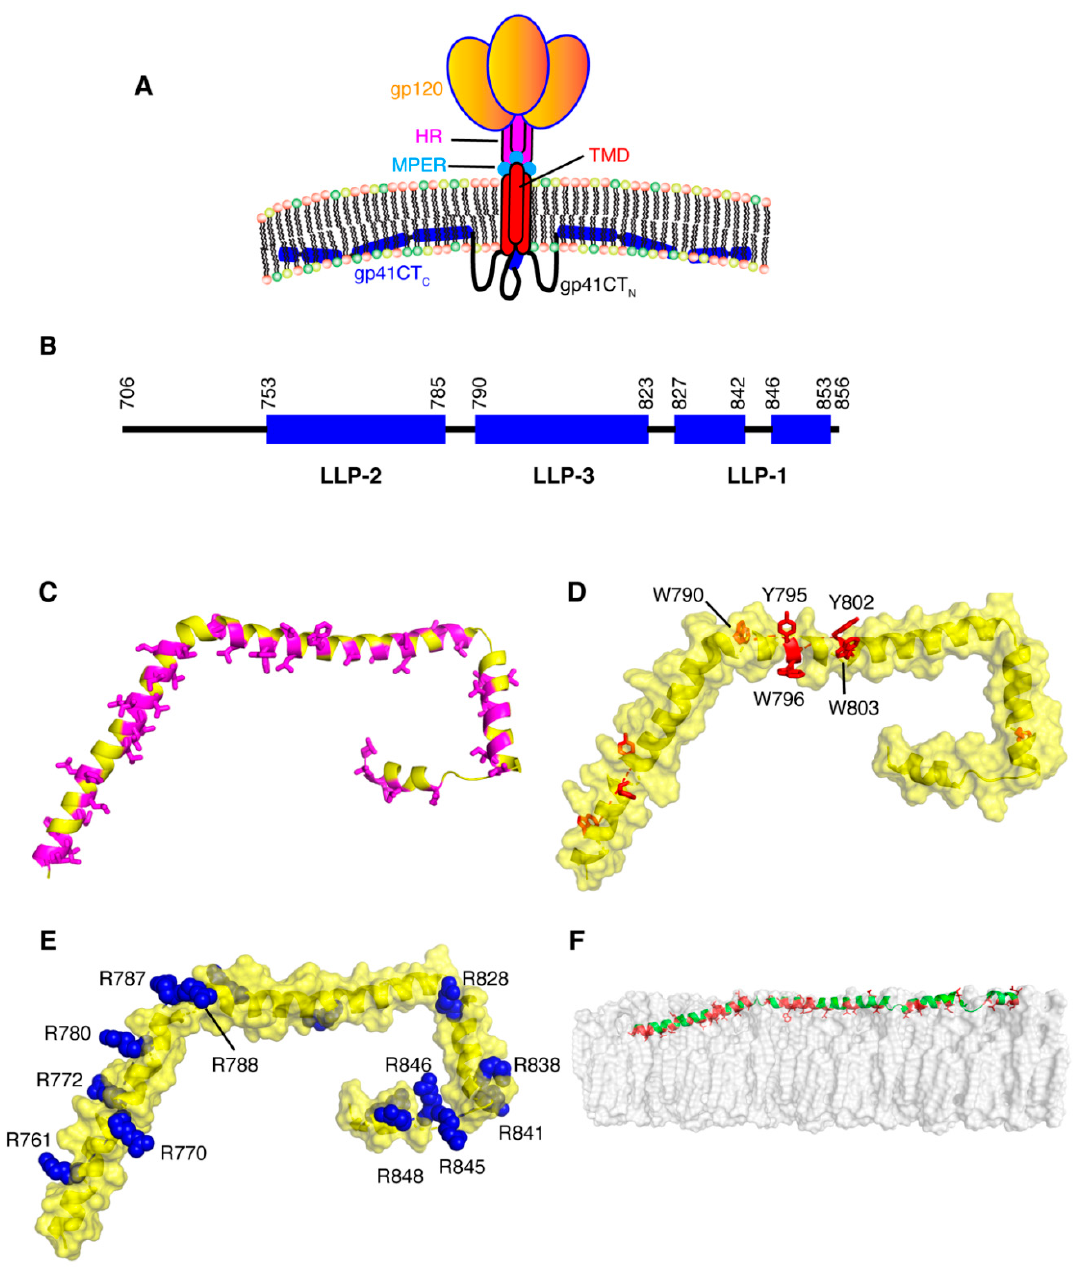
Figure 4. Structural features of the gp41CT protein. ( A ) A model depicting the gp120 and gp41 proteins on the surface of an HIV ‐ 1 particle. ( B ) Schematic representation of the gp41CT protein sequence with secondary structure illustration. ( C ) Cartoon representation of gp41CT C showing the extensive hydrophobic interface formed by Leu, Ile, Val, Ala, Trp and Phe residues (magenta). ( D ) Surface representation of gp41CT C showing aromatic residues as red sticks. Of particular interest is the cluster of aromatic residues at the beginning of LLP3, which harbors the Y795/W796 motif implicated in Env incorporation [114–116]. The majority of aromatic residues are buried in the interior of membrane. ( E ) Surface representation of the gp41CT C protein showing Arg and Lys residues (blue). ( F ) A model of gp41CT C bound to a membrane bilayer. Residues colored in red interact extensively with the interior of the membrane. Membrane bilayer was generated in VMD membrane builder plug-in [53].